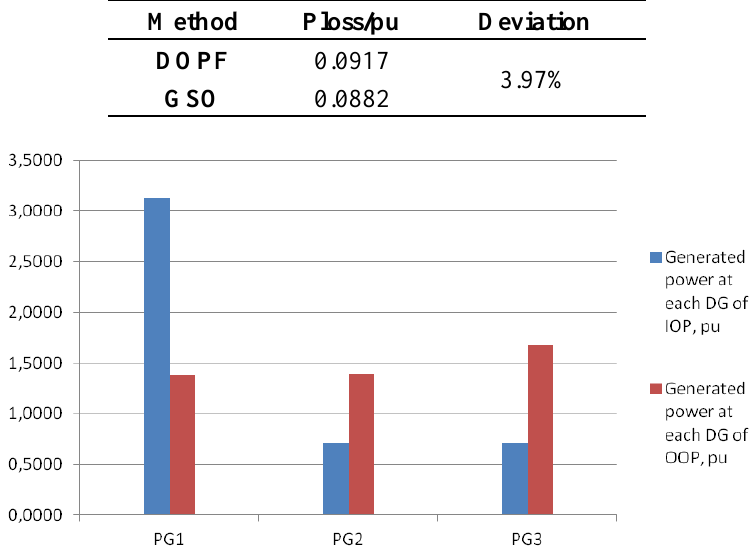
Table 5. Comparison of results between Glow-worm Swarm Optimization (GSO) and DOPF.